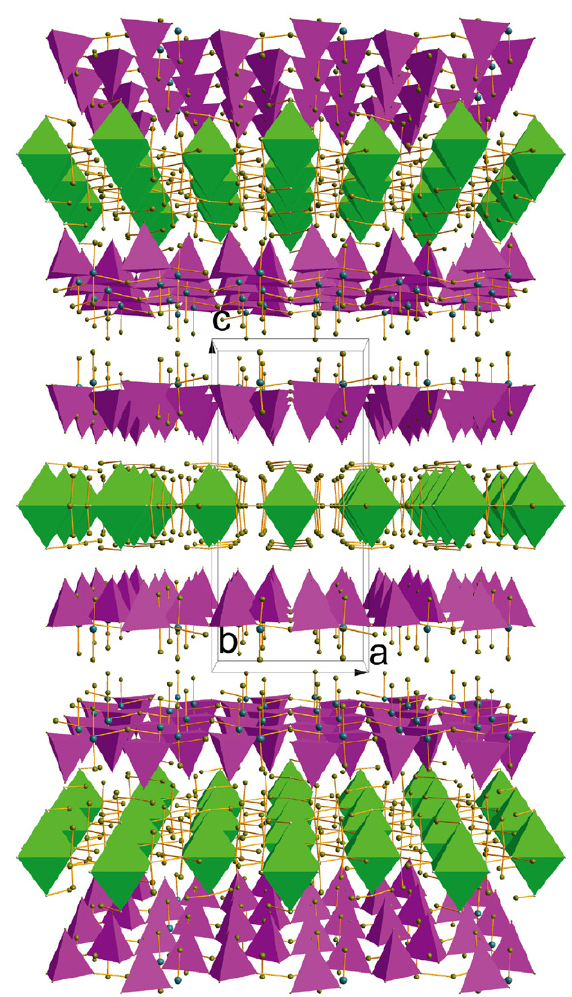
Figure 3. A packing diagram of compound 1 .